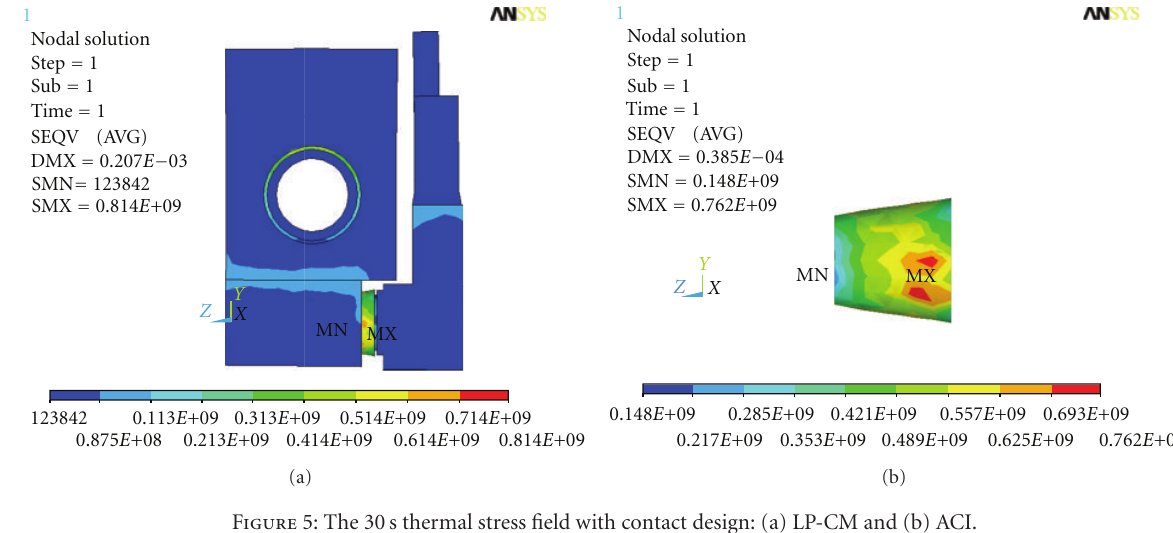
Figure 5: The 30s thermal stress field with contact design: (a) LP-CM and (b) ACI.